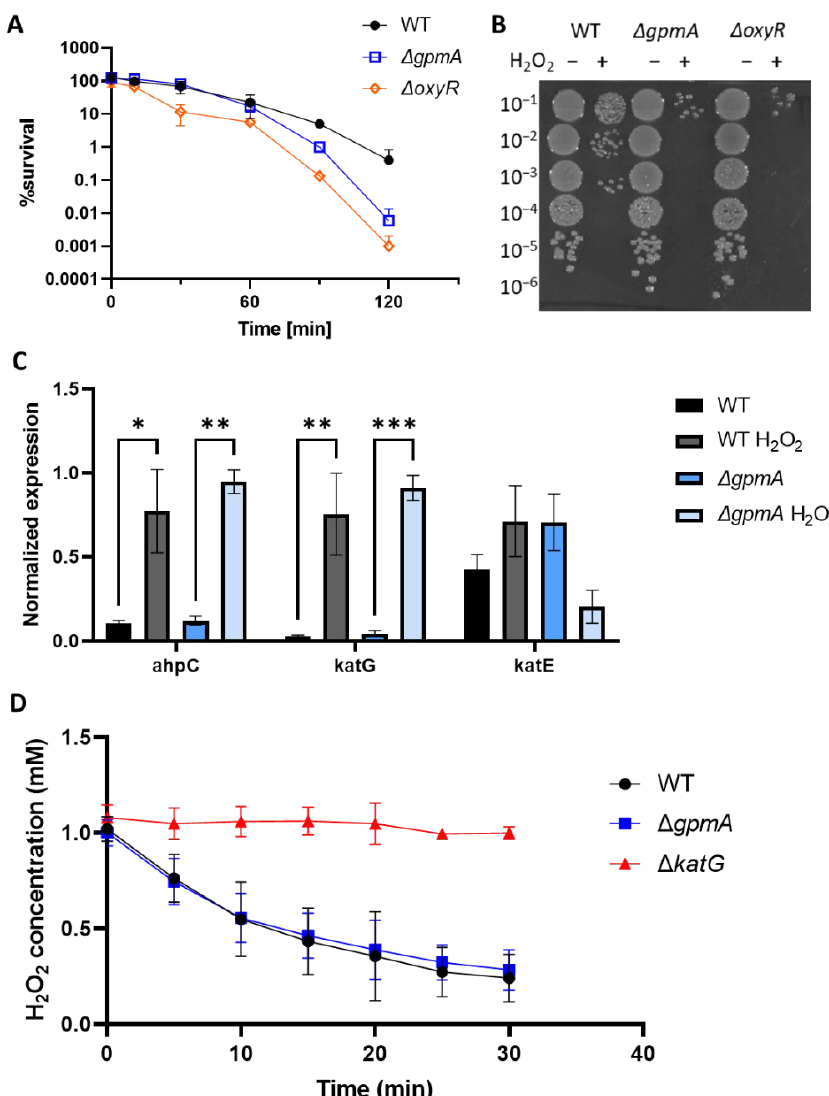
Figure 5. WT and gpmA displayed no difference in catalase expression and activity. ( A ) Survival of 2 × 10 7 cells of WT (black), ∆ gpmA (blue) and ∆ oxyR (orange) over time after an exposure to 2.5 mM H 2 O 2 in liquid LB (mean +/ − SD, N = 3). ( B ) Representative image of the survival 2h after H 2 O 2 treatment. Each spot represents 10 µ L at the given dilution factor. ( C ) Expression levels of ahpC , katG and katE in WT (black) or Δ gpmA (blue) 10 min after the addition of 2.5 mM H 2 O 2 or corresponding control (mean +/ − SEM, N = 3). Data were analyzed by Welch T-test, and *, **, *** correspond to p < 0.05, 0.01, 0.001, respectively. ( D ) Degradation of 1 mM H 2 O 2 over time by WT (black), Δ gpmA (blue) and Δ katG (red) assessed by Amplex Red (mean +/ − SD, N = 3).